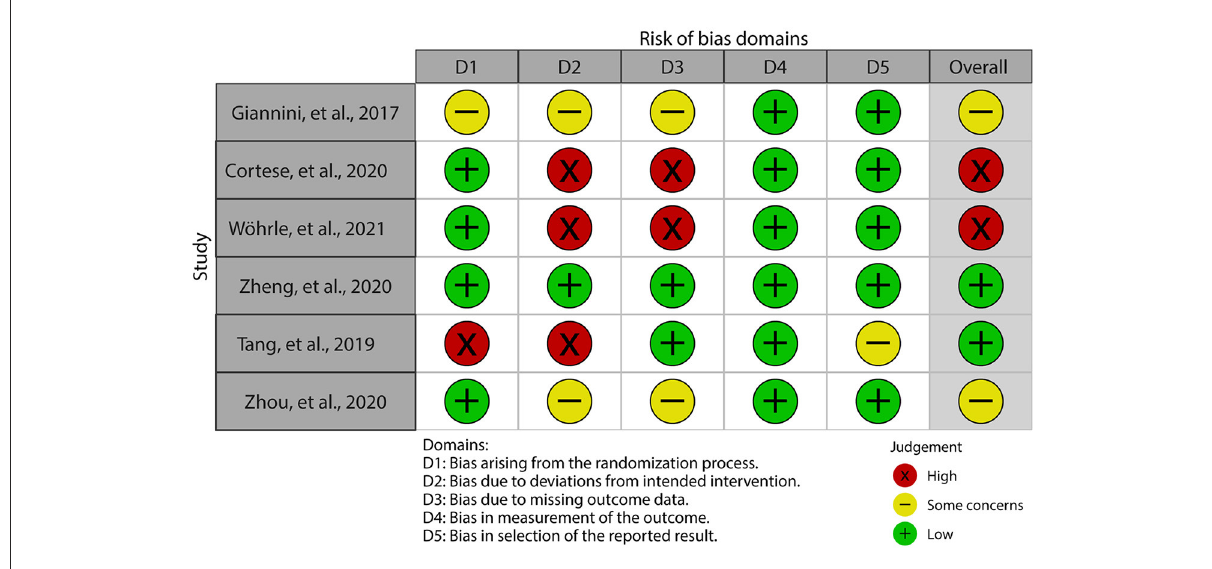
FIGURE2 Risk of bias summary based on RoB 2.0. RoB, risk of